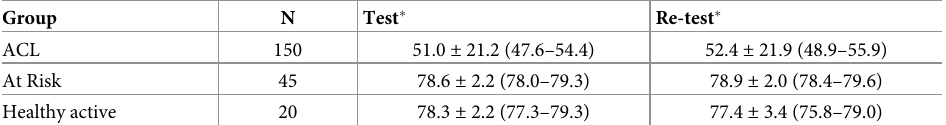
Table 6. Total scores of the LEFS-SMAr questionnaire in the groups of